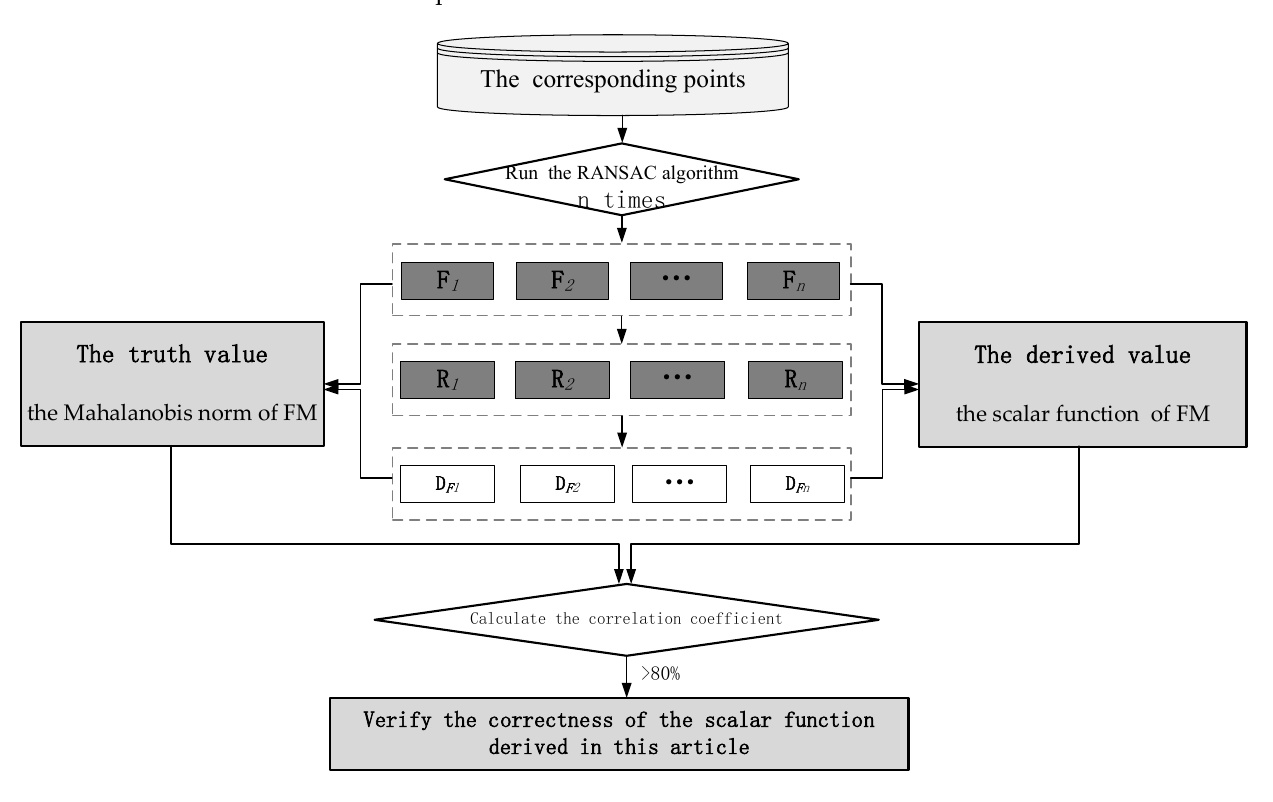
Figure 5. Verification flowchart of the proposed method.